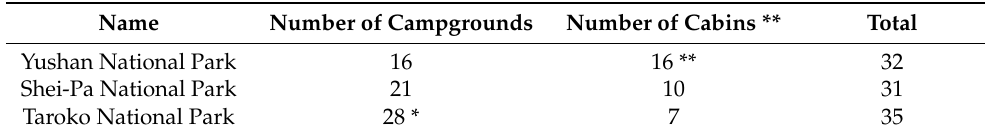
Table 2. The number of accommodation facilities in the alpine zones of the three national parks in Taiwan.